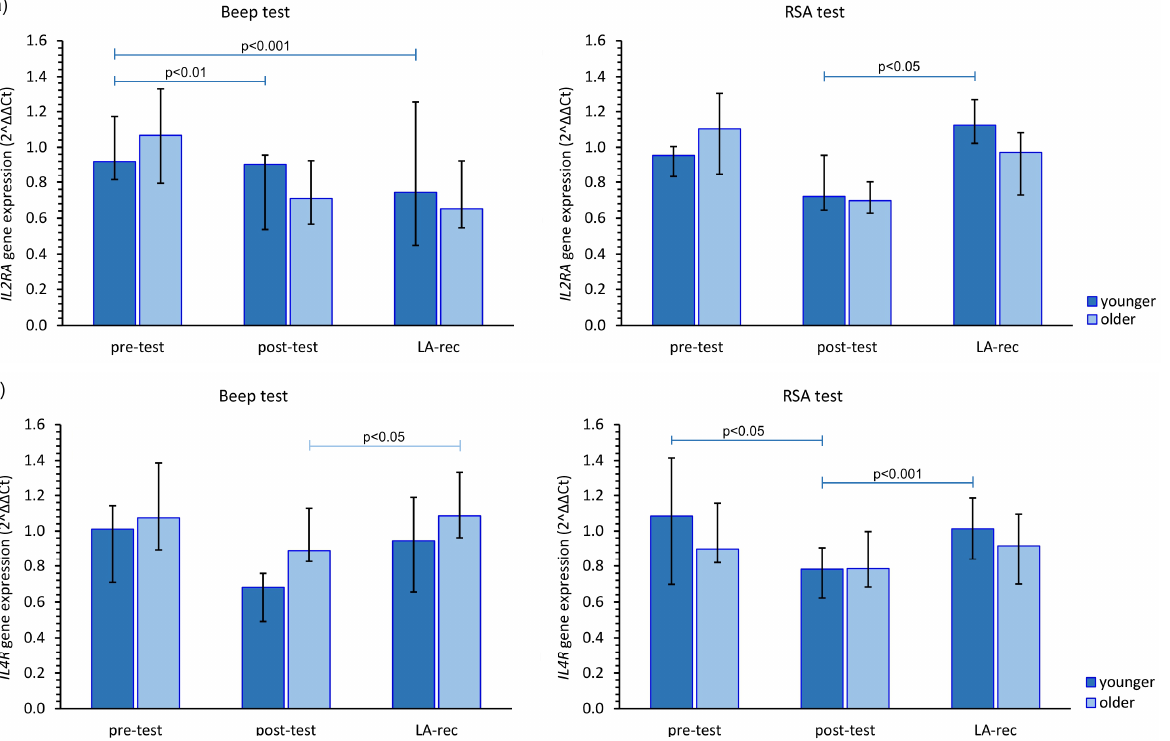
Figure 4. The impact of aerobic (Beep test) and anaerobic (RSA test) effort on the relative expression of studied genes encoding ( a ) IL2RA , ( b ) IL4R , ( c ) IL6R , ( d ) IL10RA , ( e ) IL17RA . The figures present